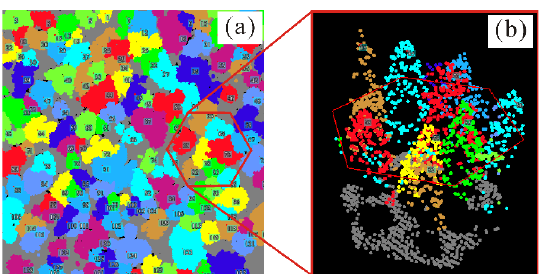
Figure 6. (a) Overall test area segmentation result map, (b) Partially enlarged 3D